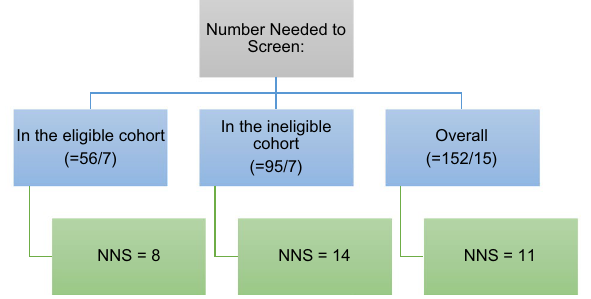
Figure 7. NNS for all patients, the eligible cohort, and the ineligible